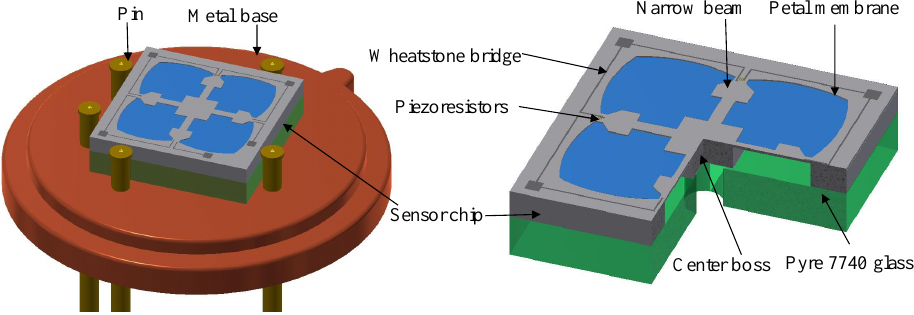
Figure 1. 3D structure of the proposed